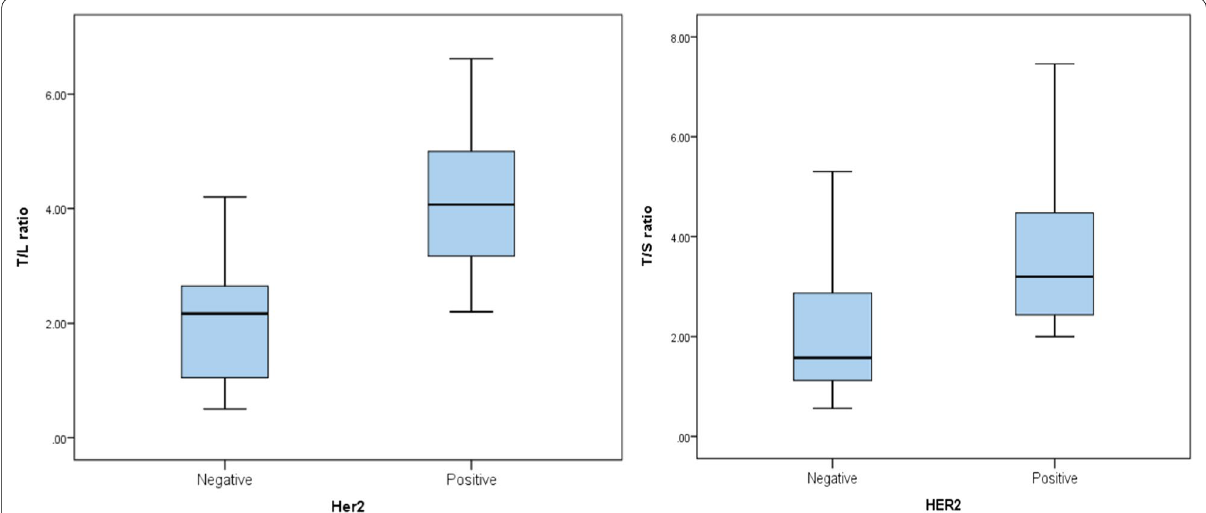
Fig. 5 Relation between the TLR and TSR and HER2 molecular